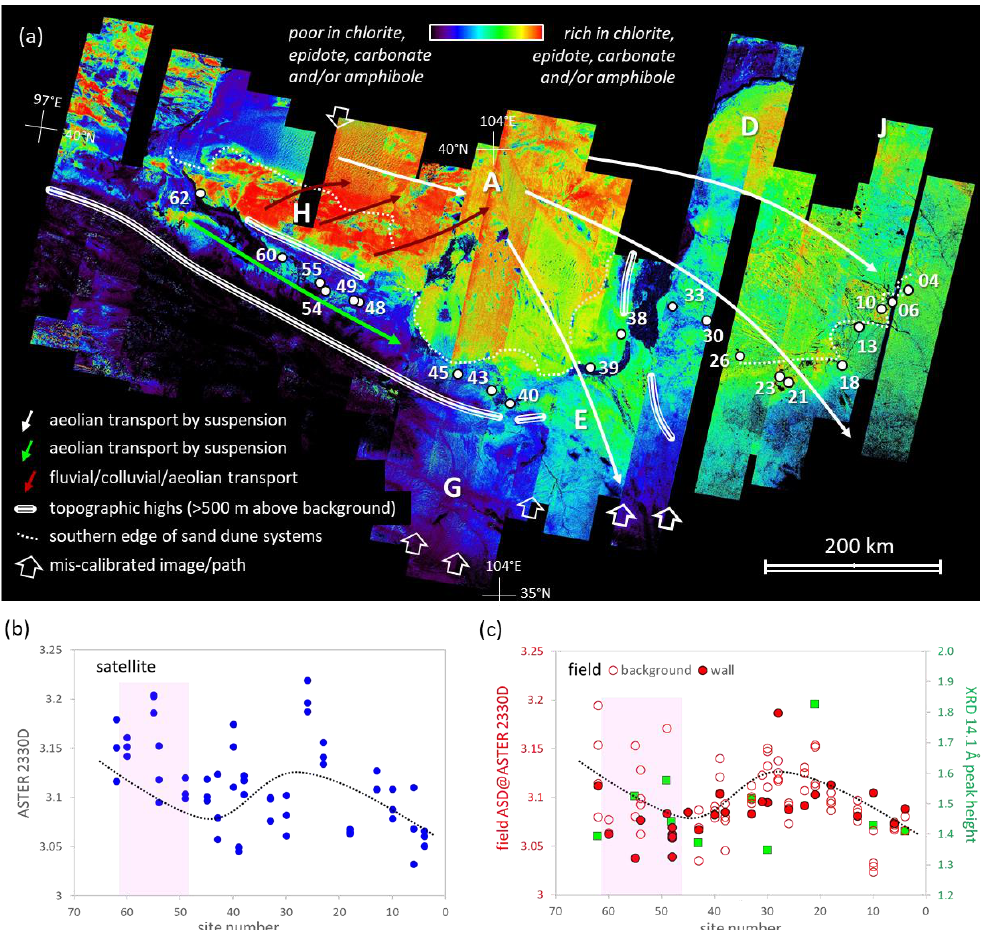
Figure 7. ( a ) Satellite ASTER 2330D mosaic, which is sensitive to the content of chlorite. ( b ) Scattergram of the west-to-east spatial trend of satellite ASTER 2330D ROI responses. ( c ) Scattergram of the west-to-east spatial trend of field 2330D responses of both wall (filled red circles) and background (open red circles) samples. These are plotted with laboratory XRD results of the 14.1 Å chlorite peak height (green boxes) for selected wall samples. A magenta box marks the well-preserved “Shandan” wall section.